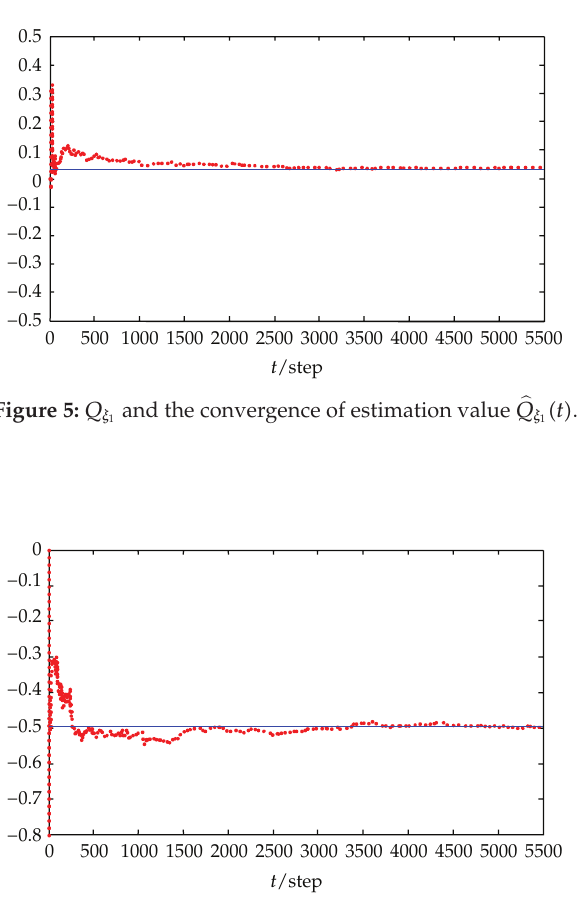
and the convergence of estimation value 1